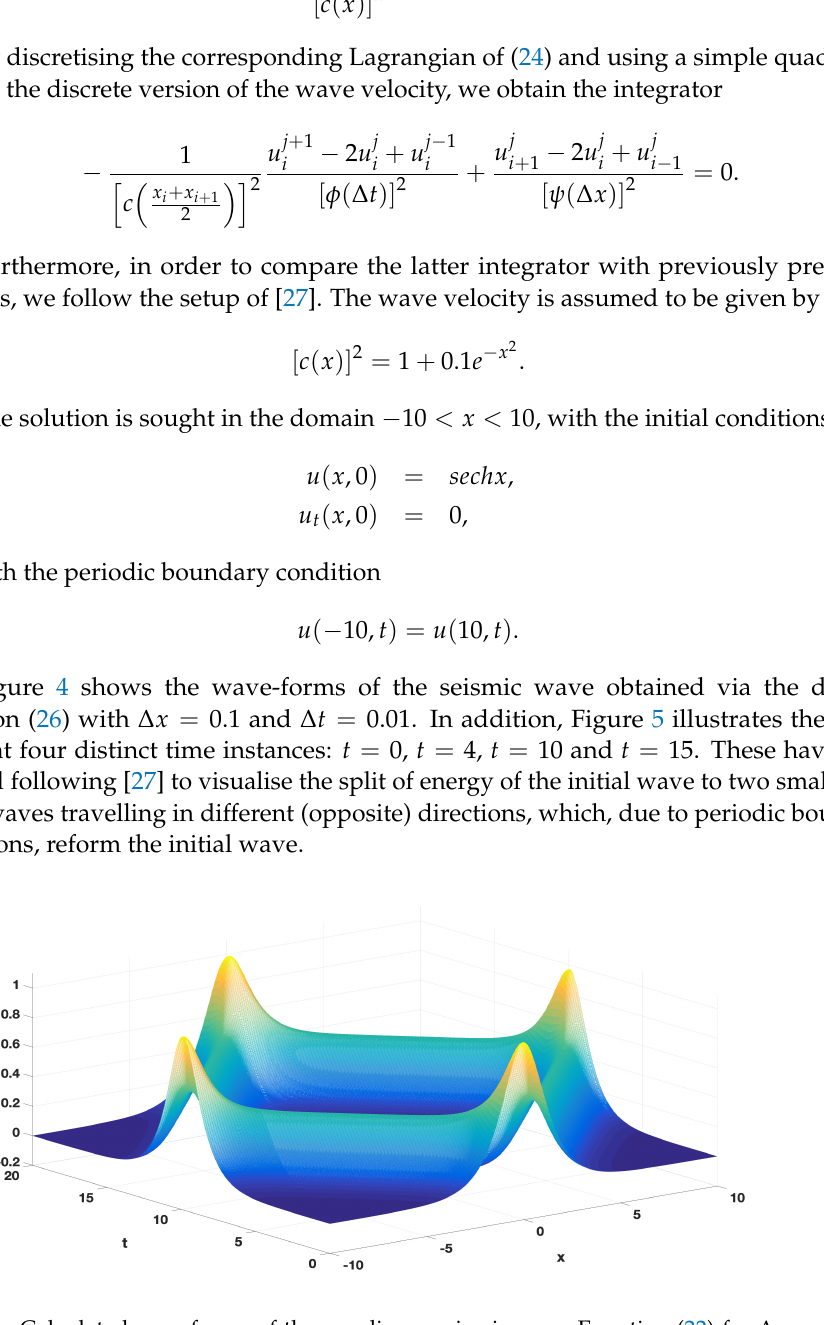
Figure 4. Calculated waveforms of the non-linear seismic wave Equation (22) for ∆ x = 0.1 and ∆ t =